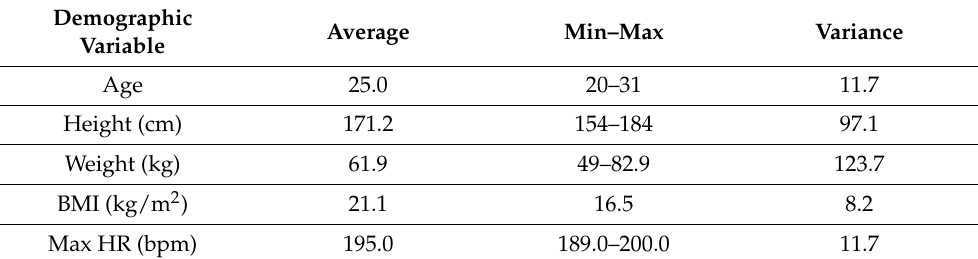
Table 2. Detailed demographic information on participants